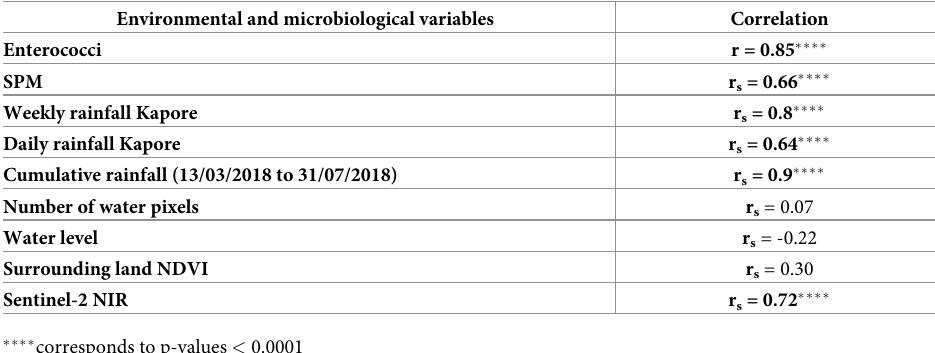
Table 1. Correlation coefficients obtained by regressing E . coli and enterococci, and E . coli and environmental variables (N = 38 for enterococci, SPM, weekly and daily rainfall; N = 16 for cumulative rainfall; N = 22 for land NDVI, Sentinel-2 data; N = 19 for water pixels and water